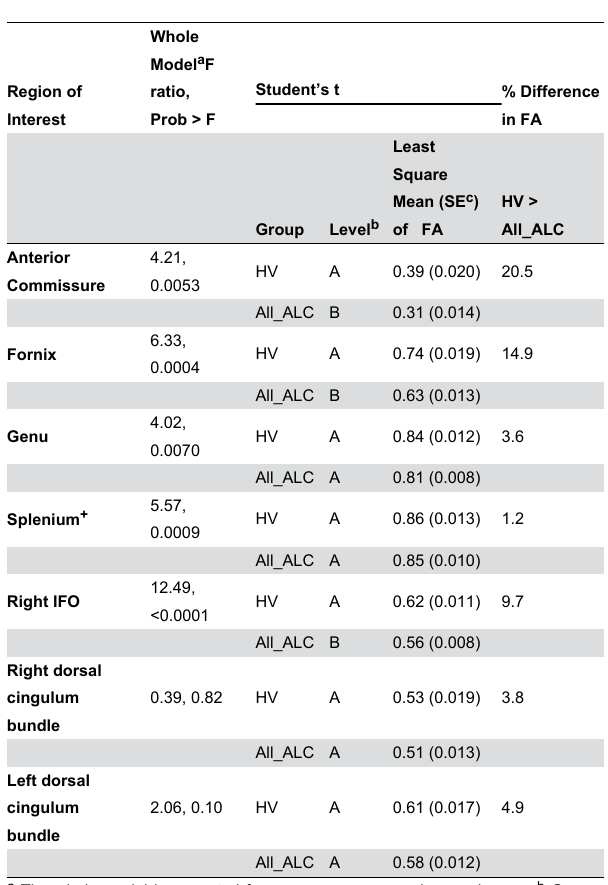
Table 3. Statistics of three-group Region of Interest analysis: HV vs ALC vs